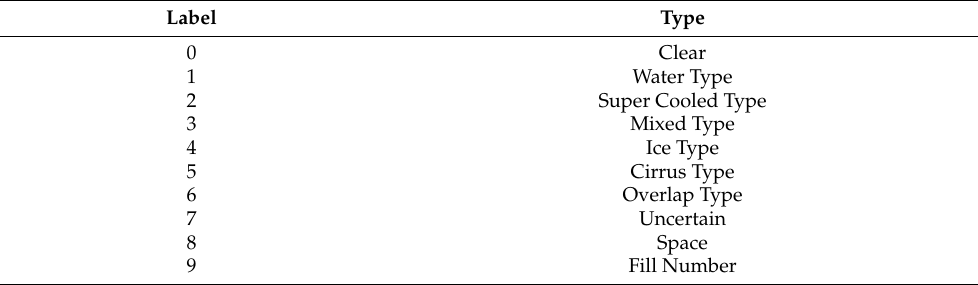
Table 3. The description of the cloud type